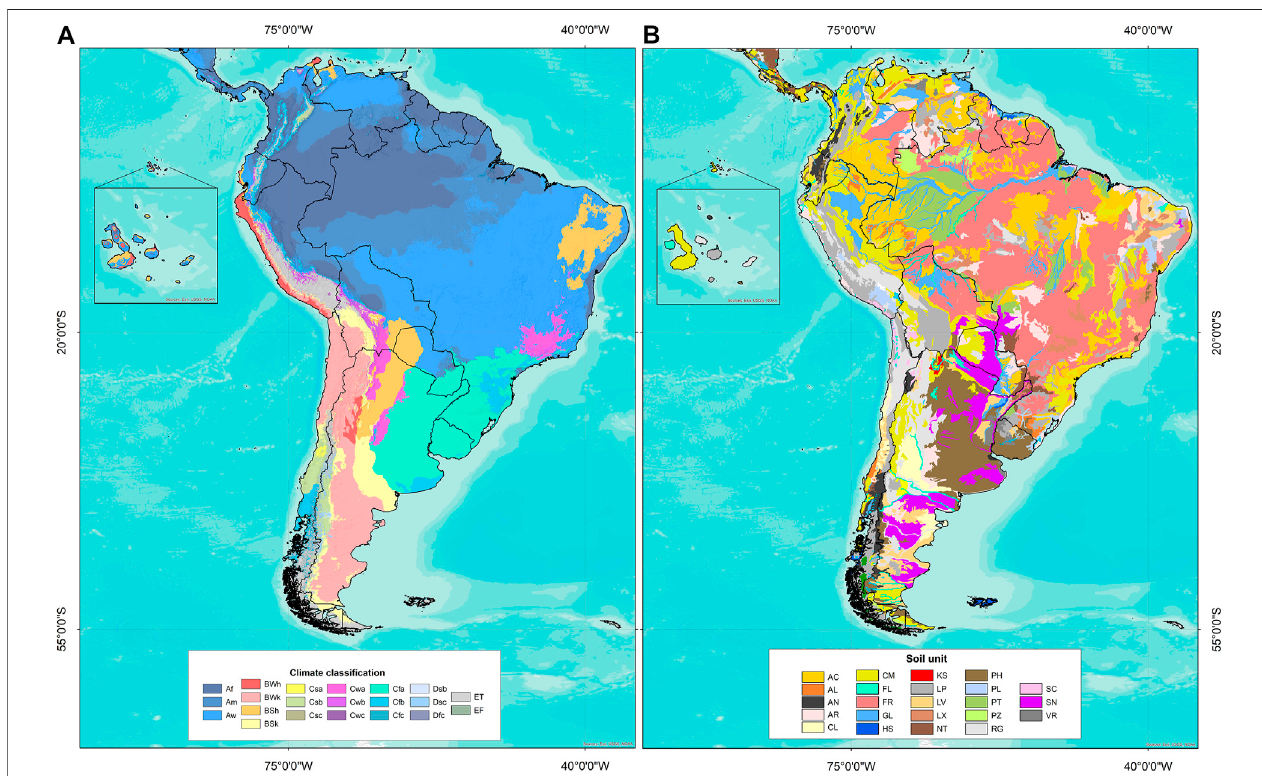
FIGURE2|(A) Climateclassi fi cationaccordingtoBecketal.(2018):Af(tropicalandrainforest),Am(tropicalandmonsoon),Aw(tropicalandsavannah),BWh(arid, desert, and hot), BWk (arid, desert, and cold), BSh (arid, steppe, and hot), BSk (arid, steppe, and cold), Csb (temperate, dry summer, and warm summer), Cwb (temperate, dry winter, and warm summer), Cfb (temperate, no dry season, and warm summer), and ET (polar, frost). (B) Soil units according to FAO/IIASA/ISRIC/ ISSCAS/JRC (2009): AC (acrisol), AL (alisol), AN (andosol), AR (arenosol), CL (calcisol), CM (cambisol), FL ( fl uvisol), FR (ferralsol), GL (gleysol), HS (histosol), KS (kastanozem), LP (leptosol), LV(luvisol),LX(lixisol),NT(nitisol),PH(phaezem),PL(planosol),PT(plinthosol),PZ (podzol),RG (regosol),SC (solonchak),SN(solonetz),VR